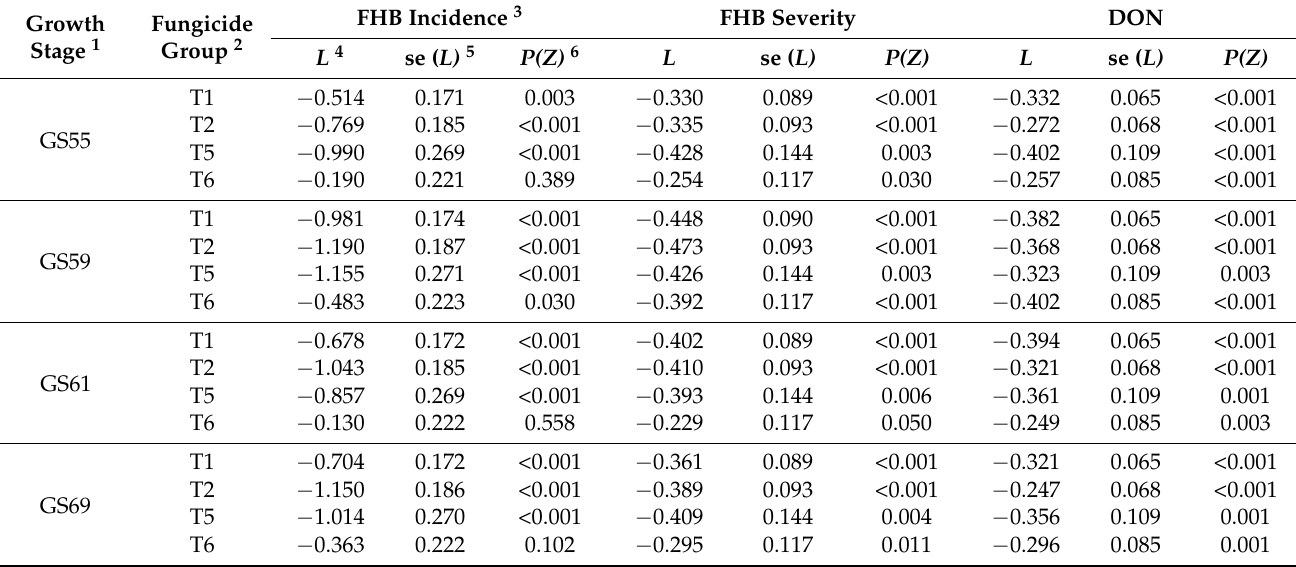
Table 4. Effect size ( L ) and corresponding statistics estimated by GLMMs of the control of Fusarium head blight (FHB) incidence, FHB severity, and DON concentration with different fungicides applied based on wheat growth stage (EXP1). Growth